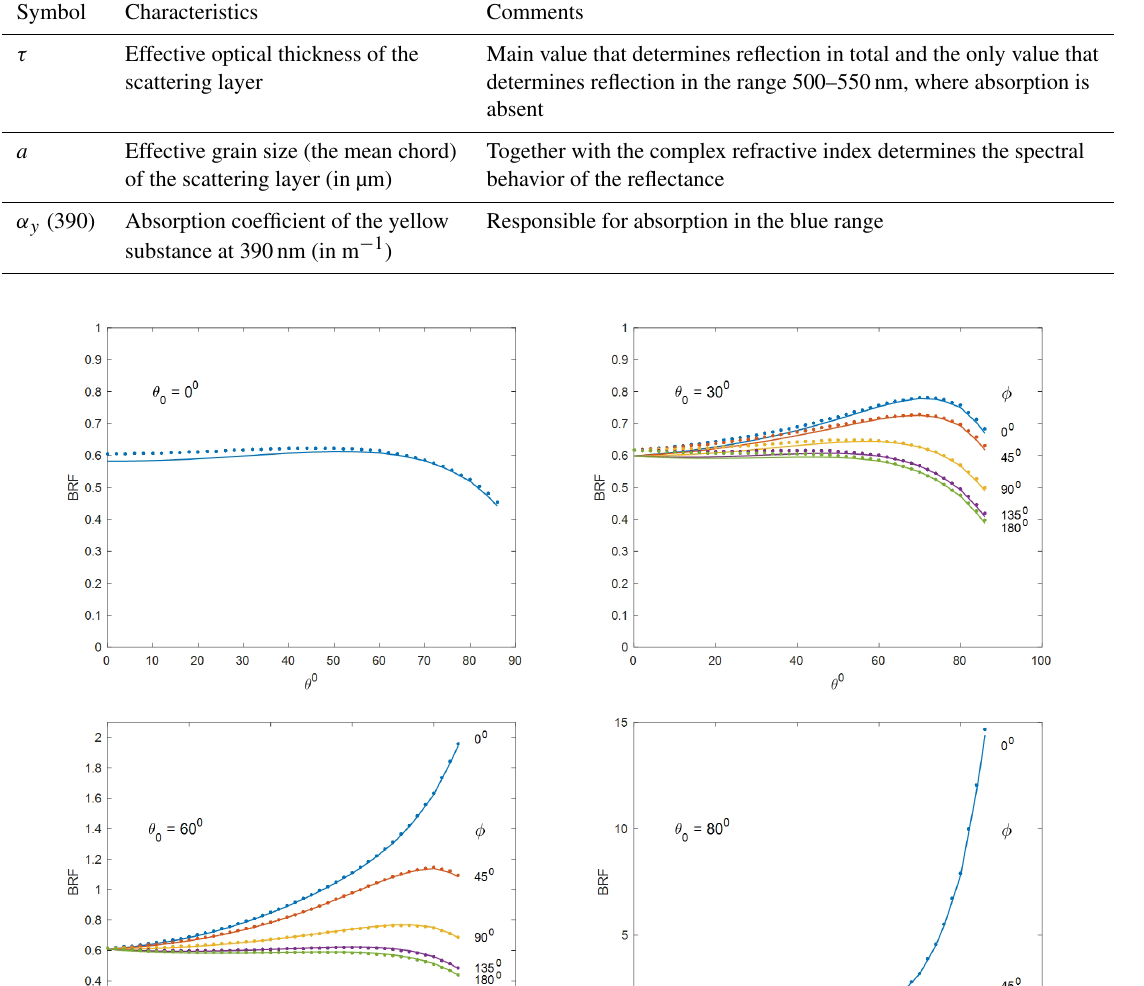
Table 1. Characteristics of white ice that determine its reflective properties.